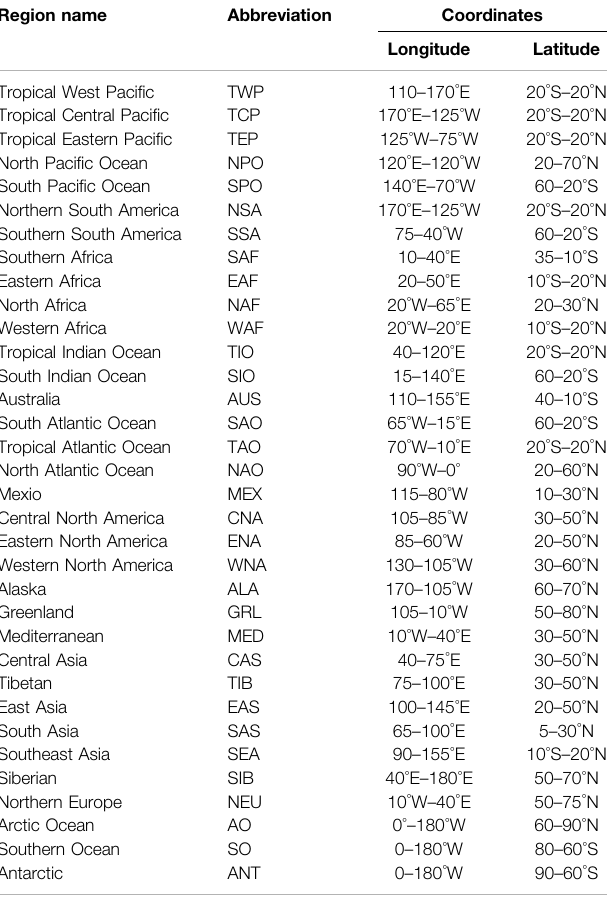
TABLE 2 | Names and coordinates for 34 regions in the